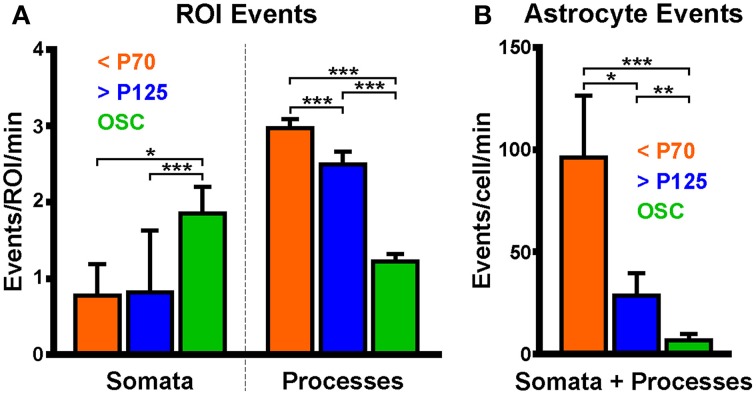
Astrocytic process event frequency varies between preparations. (A) Spontaneous astrocyte event frequency per ROI in somas and processes. Data were separated into three groups according to which preparation or age of rat was used. (B) Spontaneous astrocyte event frequency per cell. Colored bars correspond to data collected from acute brain slices obtained from young (orange; <P70) or old (blue, >P125) animals or from hippocampal organotypic slice cultures (green; OSC). Plots display mean ± SEM. Kruskal-Wallis ANOVA using Dunn's post-hoc test was used to detect differences in the medians of each group. Significant differences between groups are denoted by *p < 0.05, **p < 0.01, and ***p < 0.0001.